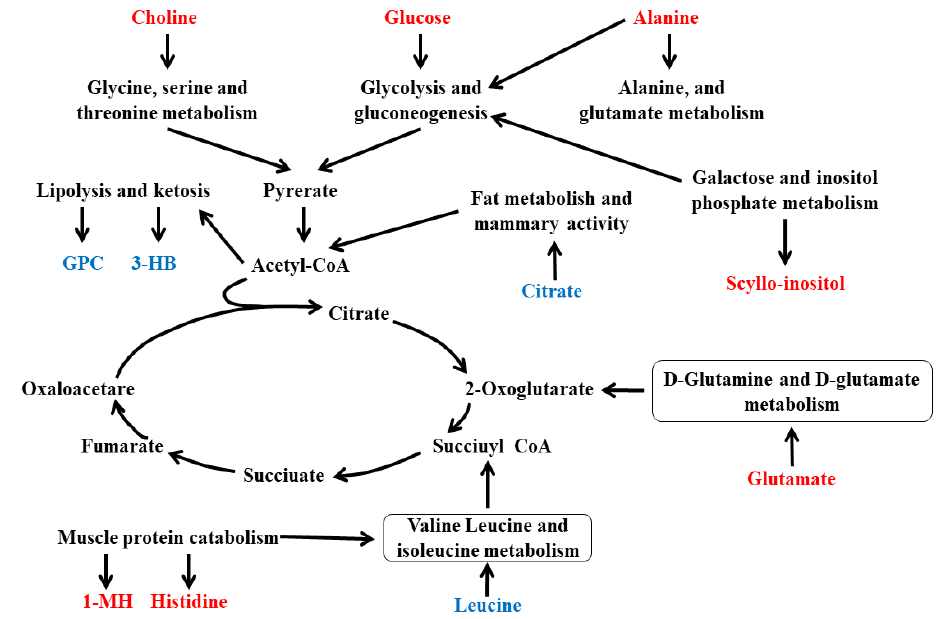
Figure 7. Metabolic network of the potential biomarkers in plasma and milk, which were different between the HS (heat stress) and TN (thermoneutral) periods. The increased metabolites in the HS period are represented in red. The decreased metabolites in the HS period are represented in blue. GPC: glycerol phosphoryl choline; 3-HB: 3-hydroxybutyrate; 1-MH: 1-Methylhistidine